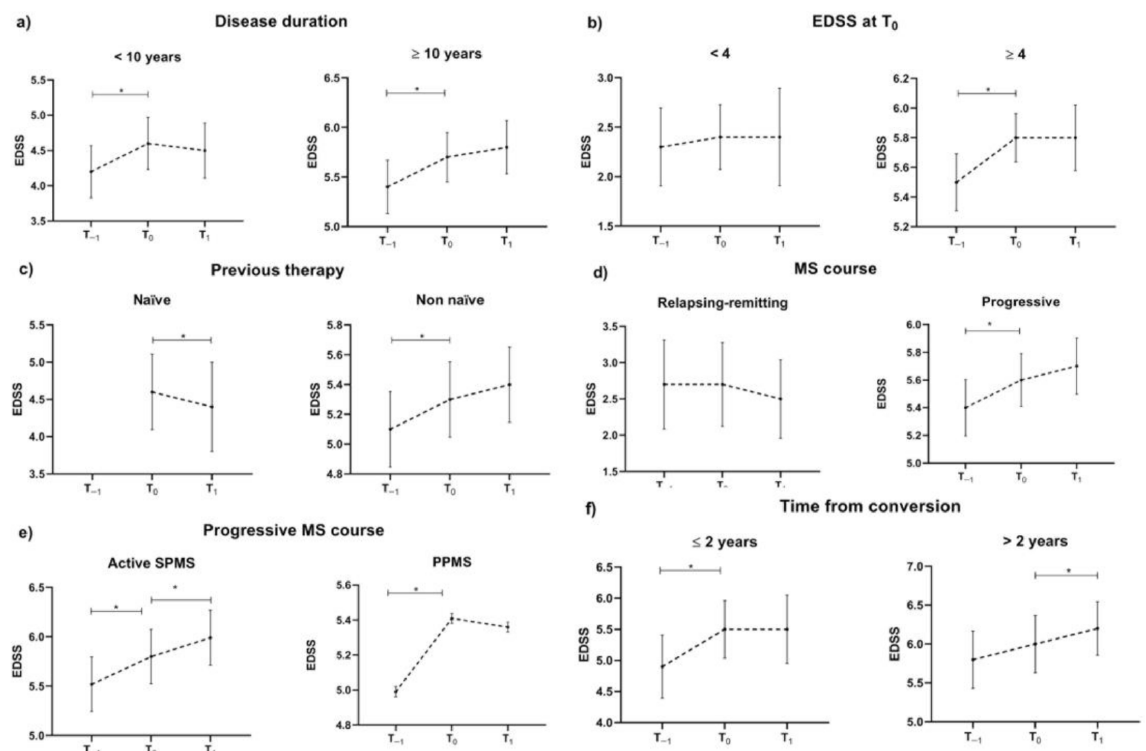
Figure 2. Post-hoc effectiveness analysis. EDSS trajectory between T − 1 , T 0 and T 1 according to disease duration ( a ), EDSS at T 0 ( b ), treatment status ( c ), MS disease course ( d , e ) and time from conversion ( f ). * p < 0.05 at multivariable mixed models including time-points as a factor of interest, EDSS as the dependent variable, age, gender and centre as covariates and subject ID as a random factor. Dash lines represent EDSS